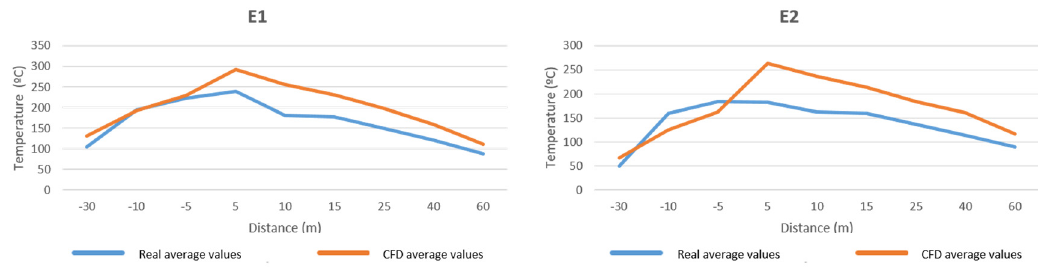
Figure 15. Comparison of FDS and experimental temperature average values along the drift; tests E1 and E2.